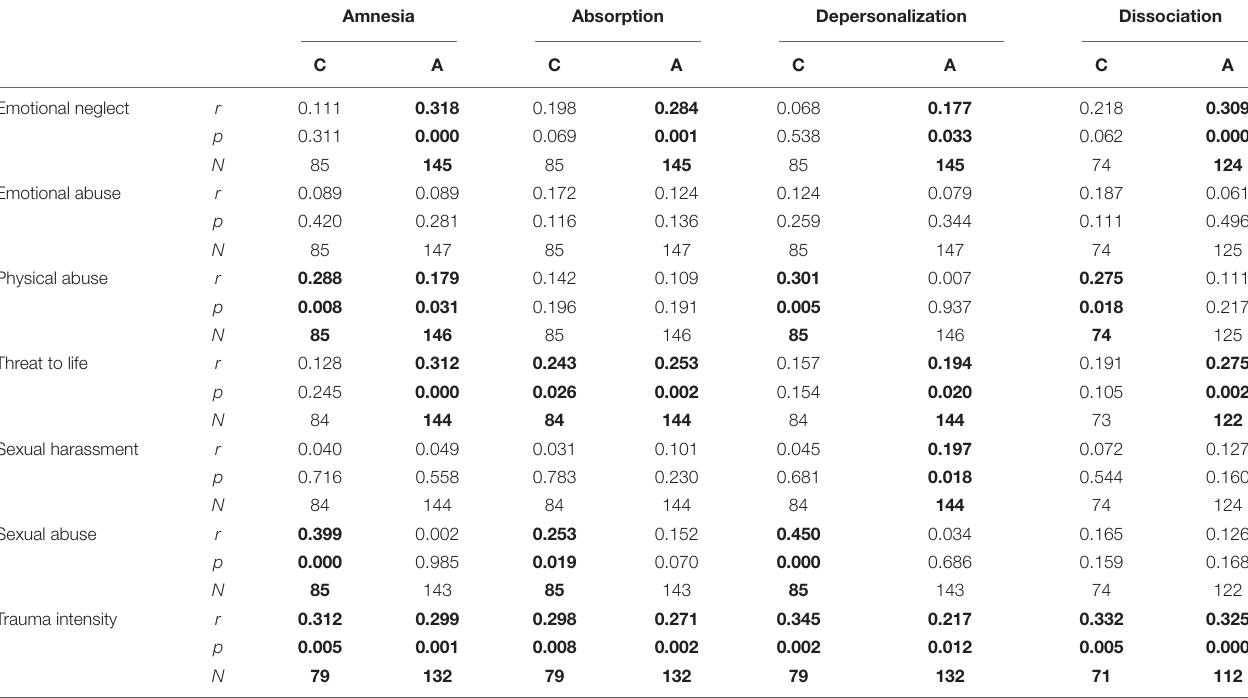
TABLE 2 | Correlation matrix between traumatic experience and tendency to dissociation. Amnesia Absorption